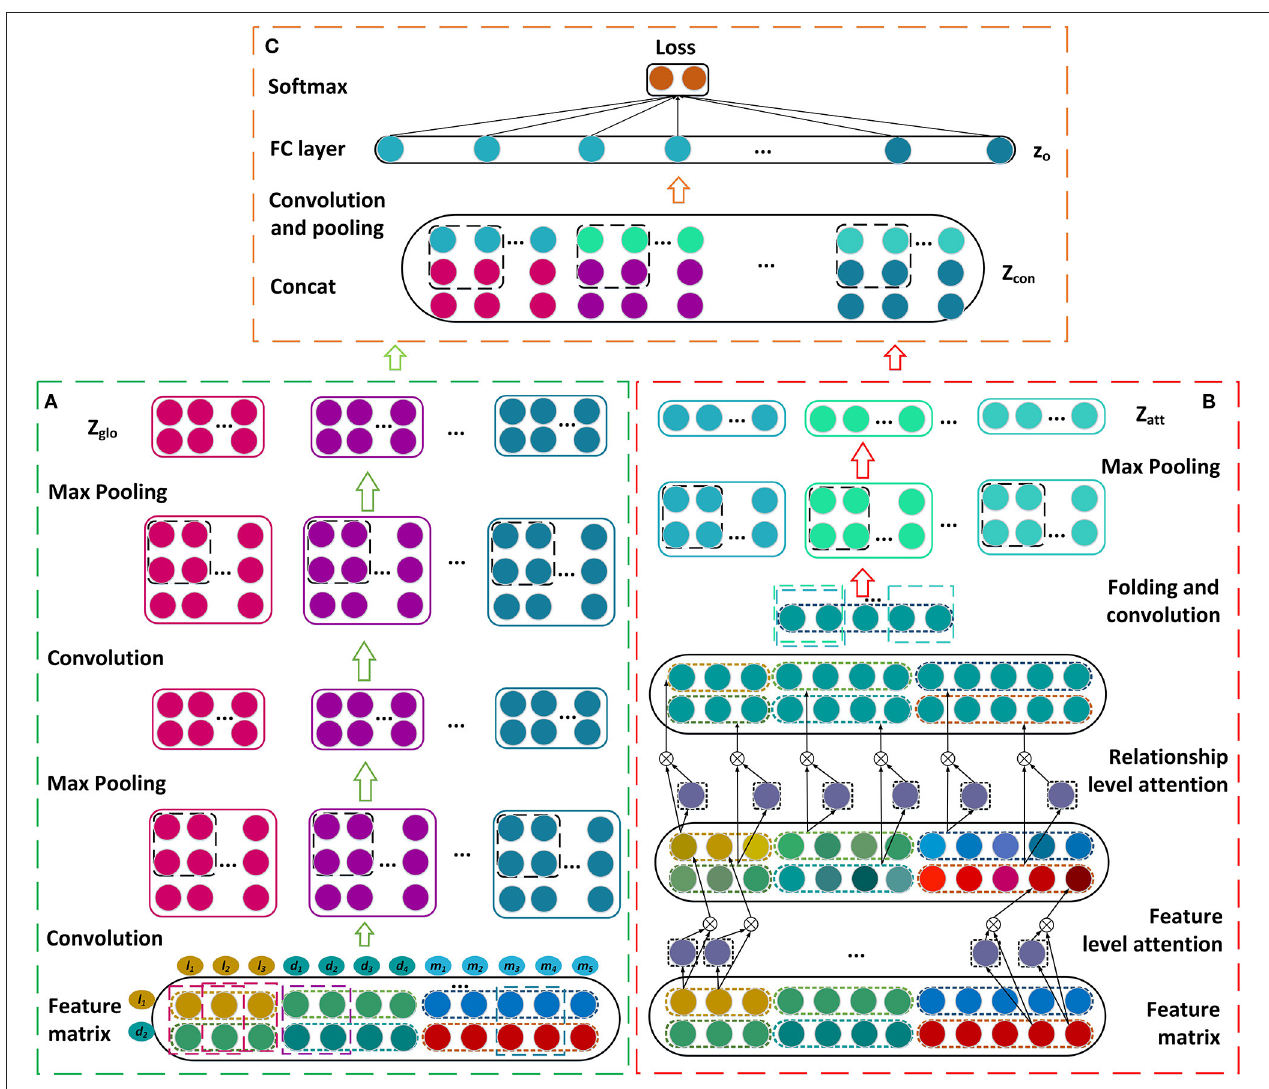
FIGURE 2 | Construction of the framework based on the dual convolutional neural networks for learning the global and attention representations. (A) Construct the convolutional and pooling layers. (B) Establish the attention mechanism at the feature and relationship levels. (C) Construct the final module to estimate the association